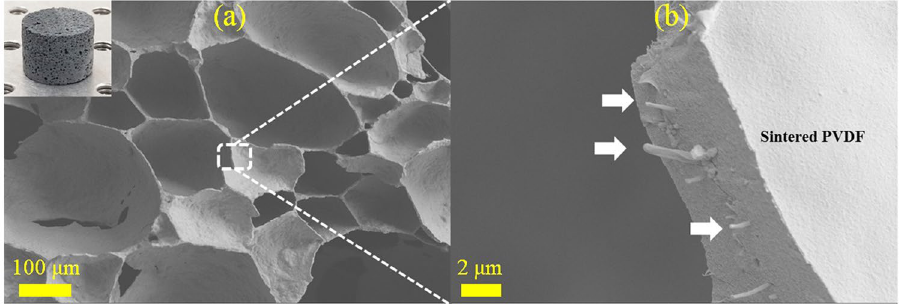
Figure 2. SEM micrographs showing ( a ) closed-cell pore structure and ( b ) CNT distribution in cell walls, for a typical PVDF/CNT porous composite.